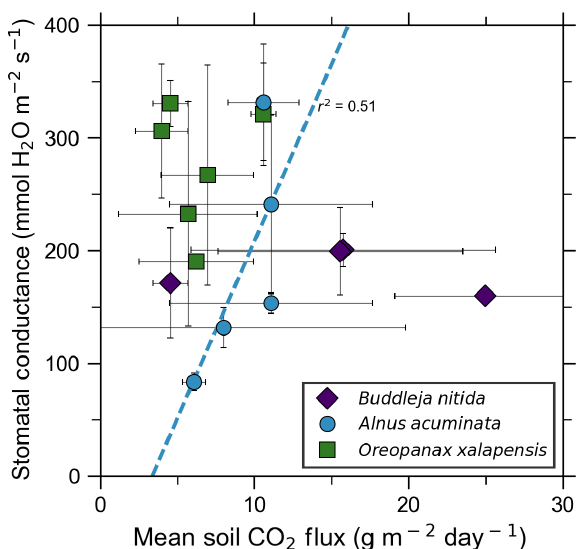
Figure 7. Leaf stomatal conductance of a tree species that strongly responds to volcanically elevated CO 2 (Figs. 5, 6) has positive cor- relations with volcanic CO 2 flux, consistent with increased gas ex-